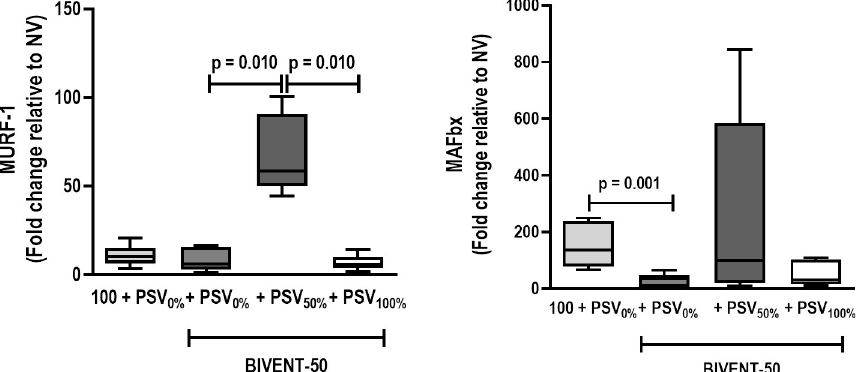
Fig 7. Real-time polymerase chain reaction analysis of biological markers for proteolysis [muscle RING finger-1 (MuRF-1) and muscle atrophy F-box (MAFbx/atrogin-1)]. Box plots represent the median and interquartile range of 8 animals. Relative gene expression was calculated as a ratio of the average gene expression levels compared with the reference gene ( 36B4 ) and expressed as fold change relative to respective NV (nonventilated). Comparisons between BIVENT-100+PSV 0% and BIVENT-50+PSV0% groups were done by the Mann–Whitney U test (p < 0.05). For comparisons within BIVENT-50 groups, the Kruskal-Wallis test with Dunn’s post-hoc test was used (p < 0.05).